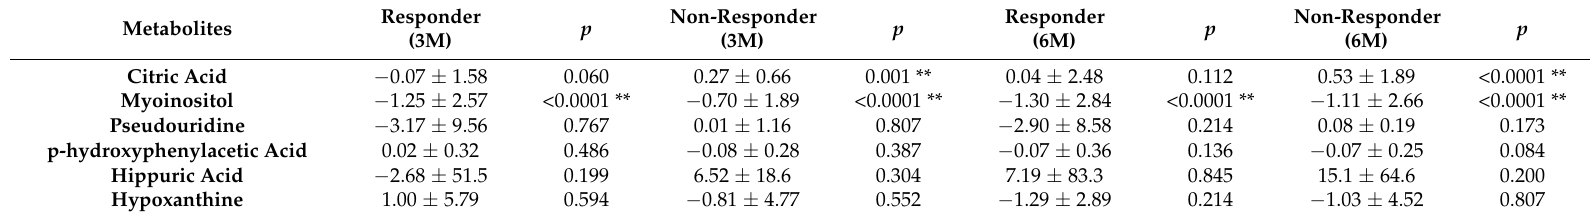
Table 3. Relative intensity levels in responder and non-responder groups after 3 (3M) and 6 months (6M) of metformin treatment compared to the